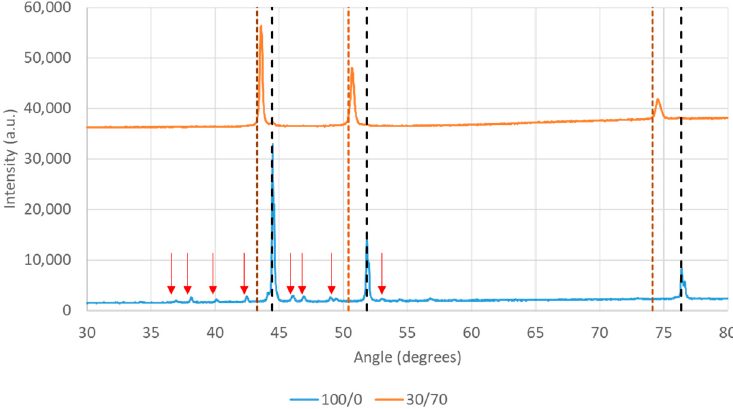
Figure 5. Peak patterns of 100/0 and 30/70 from X-ray diffraction analysis. The black dotted line represents the peak pattern of elemental nickel, and the copper-red dotted line represents the peak pattern of elemental copper. The red arrows indicate the peak positions of the nickel boride phase (Ni 3 B).